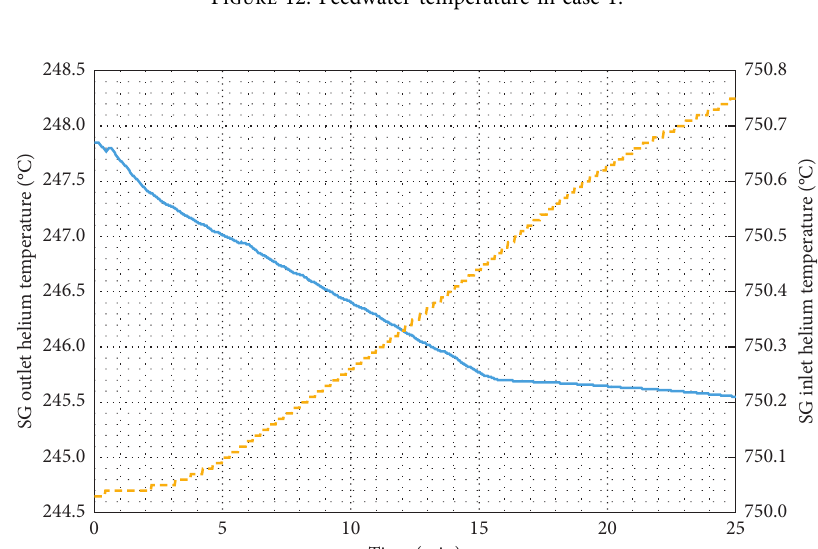
Figure 13: SG outlet and inlet helium temperature of #1 module in case 1 (solid line: outlet; dashed line: inlet).